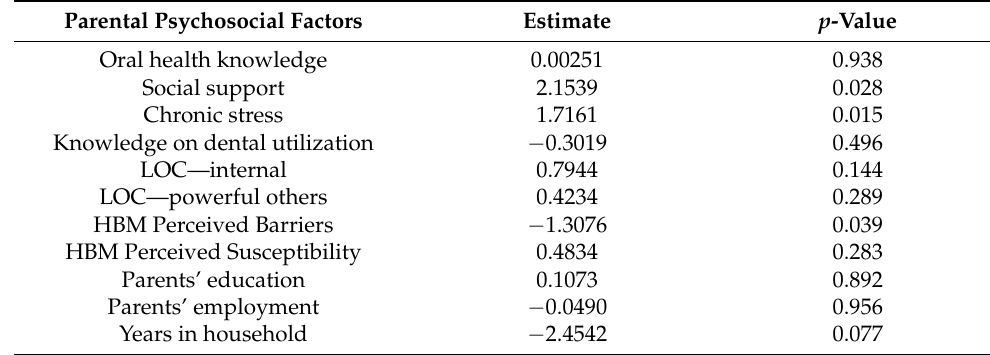
Table 3. Final model for association of acculturation with significant parental factors, adjusting for parental SES. Outcome: acculturation (more/less) ( p <